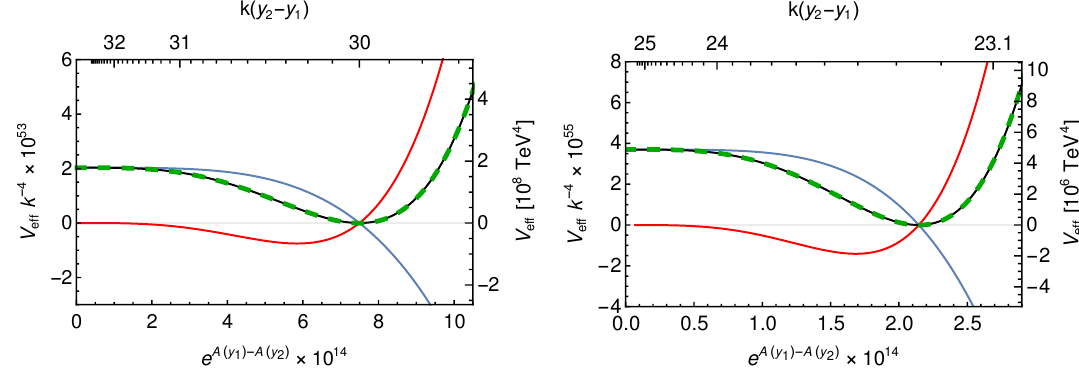
Figure 2 . E(cid:11)ective potential V e(cid:11) and its contributions as function of (cid:31) g = e A ( y 1 ) (cid:0) A ( y 2 ) (on the upper axis we show units related to the distance between the branes: k(cid:31) y = k ( y 2 (cid:0) y 1 )). The left vertical axis is given in units of k 4 and the right one, in TeV 4 . The blue and red lines are the UV ( V UV ), and IR ( V IR ) parts respectively. The black line is the total e(cid:11)ective potential. e(cid:11) e(cid:11) These three curves have been computed using (2.34). The dashed green line is also the e(cid:11)ective potential but calculated with (2.37). The agreement is perfect. On the left we show the calculation for a model with a quadratic bulk potential (3.1), and on the right, a model with an exponential bulk potential (3.2). In both cases, (cid:20) = 0 : 5 k (cid:0) 3 = 2 and we work in the sti(cid:11) wall approximation for the brane potentials. The parameters on the left are (cid:15) = 0 : 1, v 1 = 0 : 106 k 3 = 2 , v 2 = 4 : 5 k 3 = 2 and (cid:3) 2 = (cid:0) 50 k 4 . On the right, (cid:13) = 0 : 1 k (cid:0) 3 = 2 , v 1 = (cid:0) 15 k 3 = 2 , v 2 = (cid:0) 3 : 3 k 3 = 2 and (cid:3) 2 = (cid:0) 72 k 4 . The relation between k and the 4D Planck mass is calculated from (2.27). For the left plot, k = 1 : 72 (cid:2) 10 15 TeV. For the right one, k = 1 : 92 (cid:2) 10 15